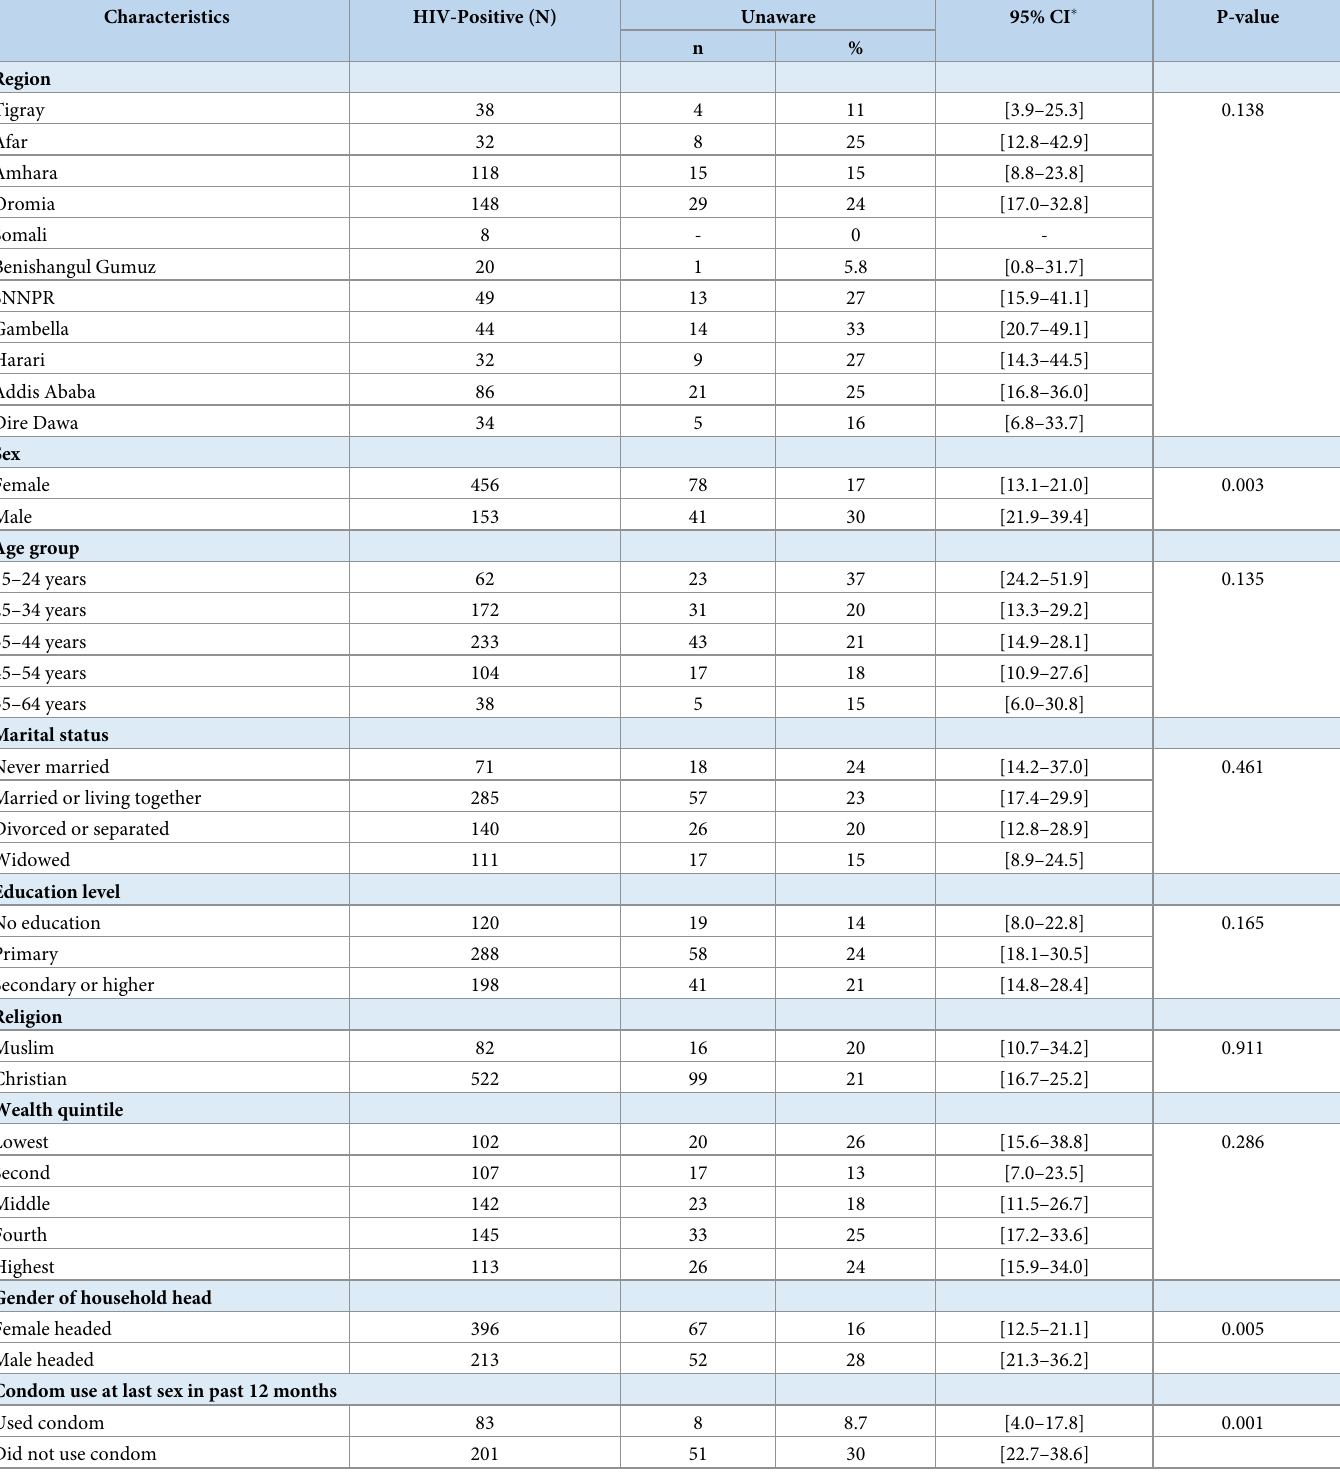
Table 2. ARV adjusted estimates of unawareness by socio demographic and behavioral characteristics among HIV-positive participants aged 15–64 years, EPHIA 2017/2018.